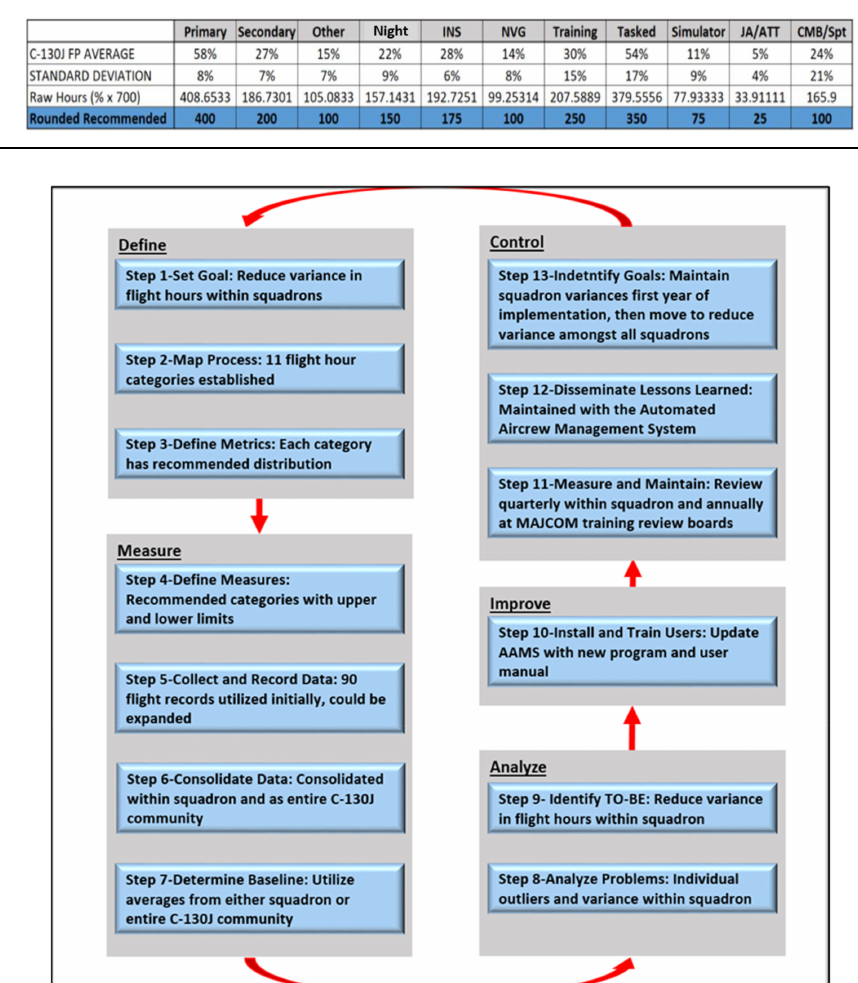
Figure 5. DMAIC method applied to C-130J pilot